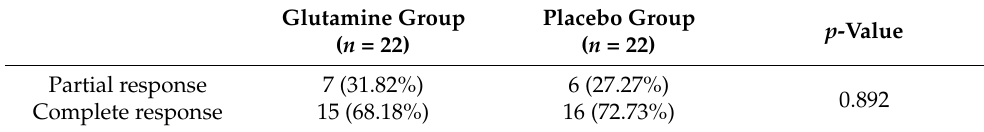
Table 2. Response to treatment in the studied groups.